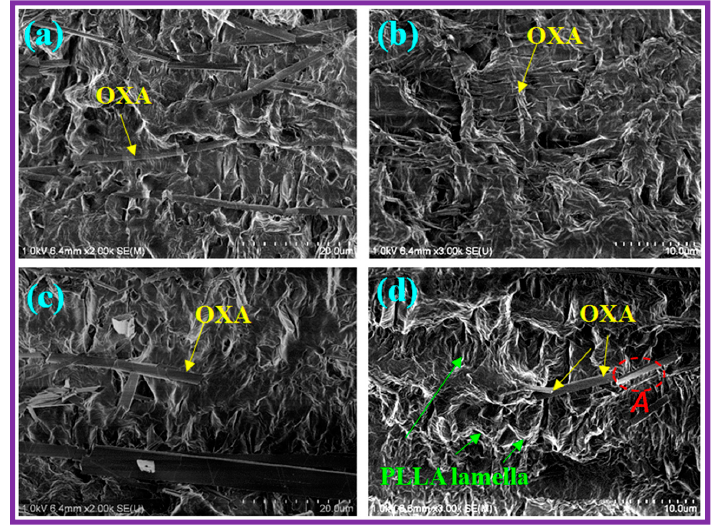
Figure 8. SEM images of the PLLA/OXA samples: ( a ) PLLA/OXA-200 just after shear; ( b ) PLLA/OXA-200 after shear and crystallization; ( c ) PLLA/OXA-240 just after shear and ( d ) PLLA/OXA-240 after shear and crystallization. The same shear condition, i.e., 0.4 rad/s for 5 s was applied to each sample and the crystallization is performed under oscillation conditions. A larger magnification of Images ( b , d ) (3000×) was used compared with that of Images ( a , c ) (2000×), for better visualization purposes.